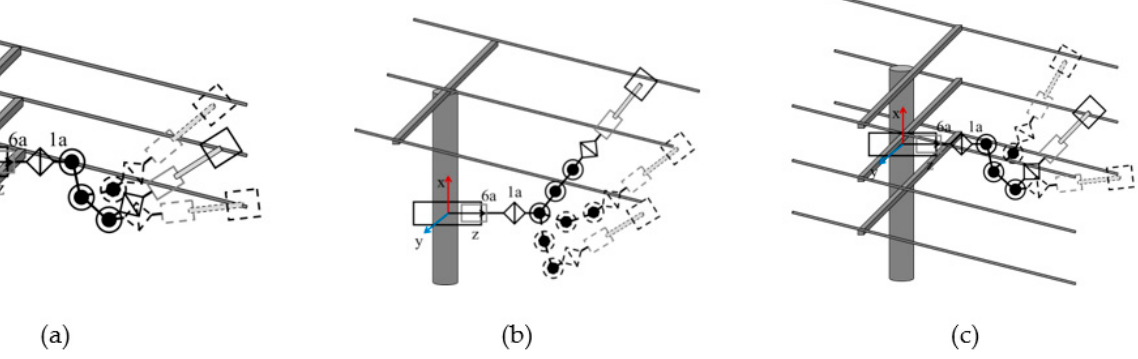
Figure 21. Operation position. ( a ) Horizontal arrangement, ( b )vertically arrangement, ( c )multi-circuit line on the same pole.